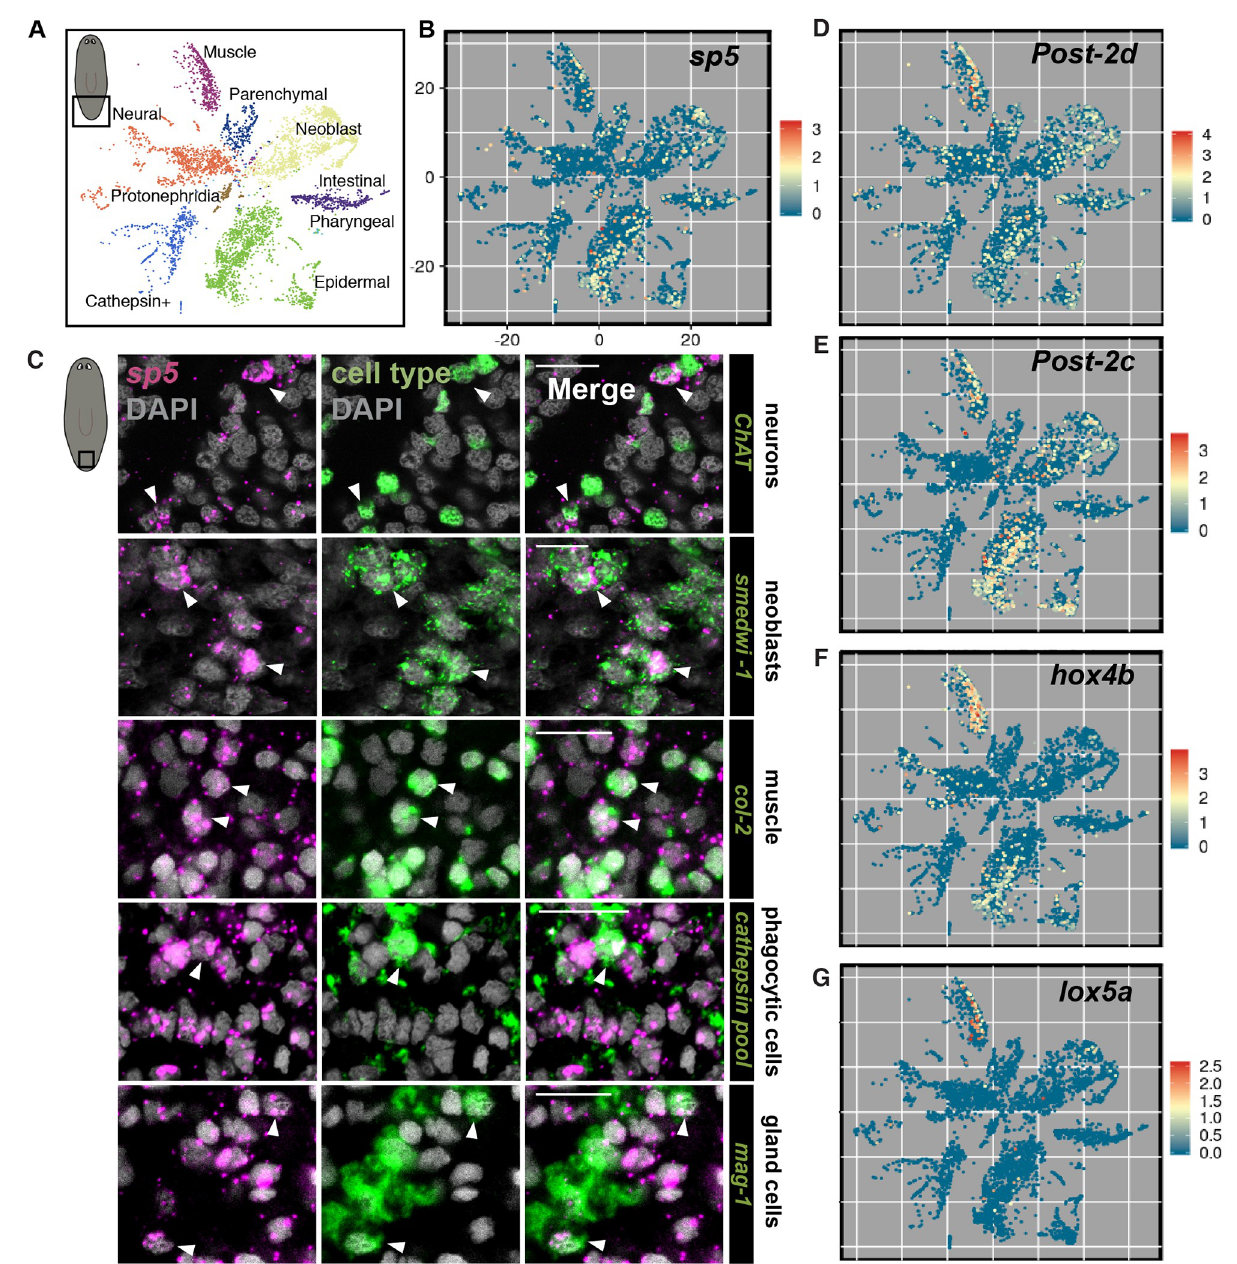
Fig 6. Planarian sp5 and Hox genes are expressed in multiple cell types in the tail. (A) t-SNE plot key of single cells from the planarian tail. Each major tissue type is labelled with a color. (B) sp5 is expressed in multiple cell types in the tail. tSNE-plot of cells obtained from the tail colored by sp5 gene expression (red, high; blue, low). (C) sp5 is expressed in all major cell types in the tail. FISH for sp5 (magenta), differentiated cell type marker (green) and DAPI (nuclear stain, grey) in uninjured planarian tails. cathepsin cells are marked by a pool of RNA probes for transcripts; dd_1161_1, pbgd-1 , if-1 , cali , dd_582 ( CTSL2 ), dd_9, dd_10872, dd_1831, dd_5690, aqp-1 (dd_1103), dd_7593, dd_6149, and dd_1260. (D) Post-2d is expressed in multiple cell types in the tail. tSNE-plot of cells obtained from the tail colored by Post-2d gene expression (red, high; blue, low). (E) Post-2c is expressed in multiple cell types in the tail. tSNE-plot of cells obtained from the tail colored by Post-2c gene expression (red, high; blue, low). (F) hox4b is expressed in muscle and epidermis in the tail. tSNE-plot of cells obtained from the tail colored by hox4b gene expression (red, high; blue, low). (G) lox5a is expressed in muscle in the tail. tSNE-plot of cells obtained from the tail colored by lox5a gene expression (red, high; blue, low). Scale bars, 10 μ m.